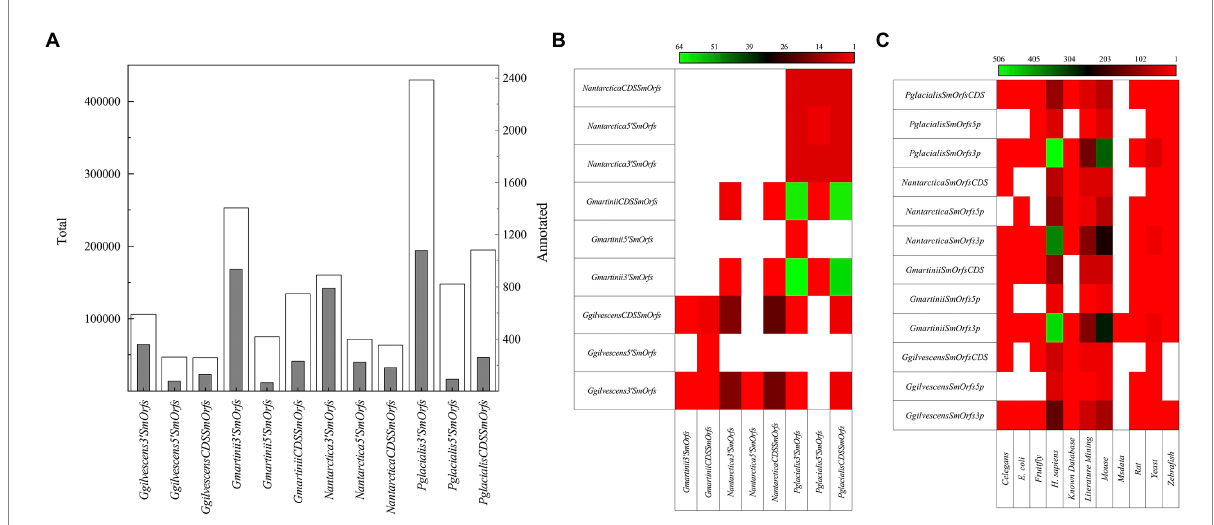
FIGURE 4 SmORFs prediction and comparison among yeasts. The total (white columns) SmORFs and those annotated (gray columns) by comparison SmOrfs database, are shown in (A) the number of translated SmORFs identical among yeasts is shown in (B) and those annotated by comparison to a SmORFs database in (C) . CDSSmORFs, SmORF located into a CDS; 5’SmORFs, SmORF located until 1,000 nt upstream of a CDS; 3’SmORFs, SmORF located until 1,000 nt downstream of a CDS